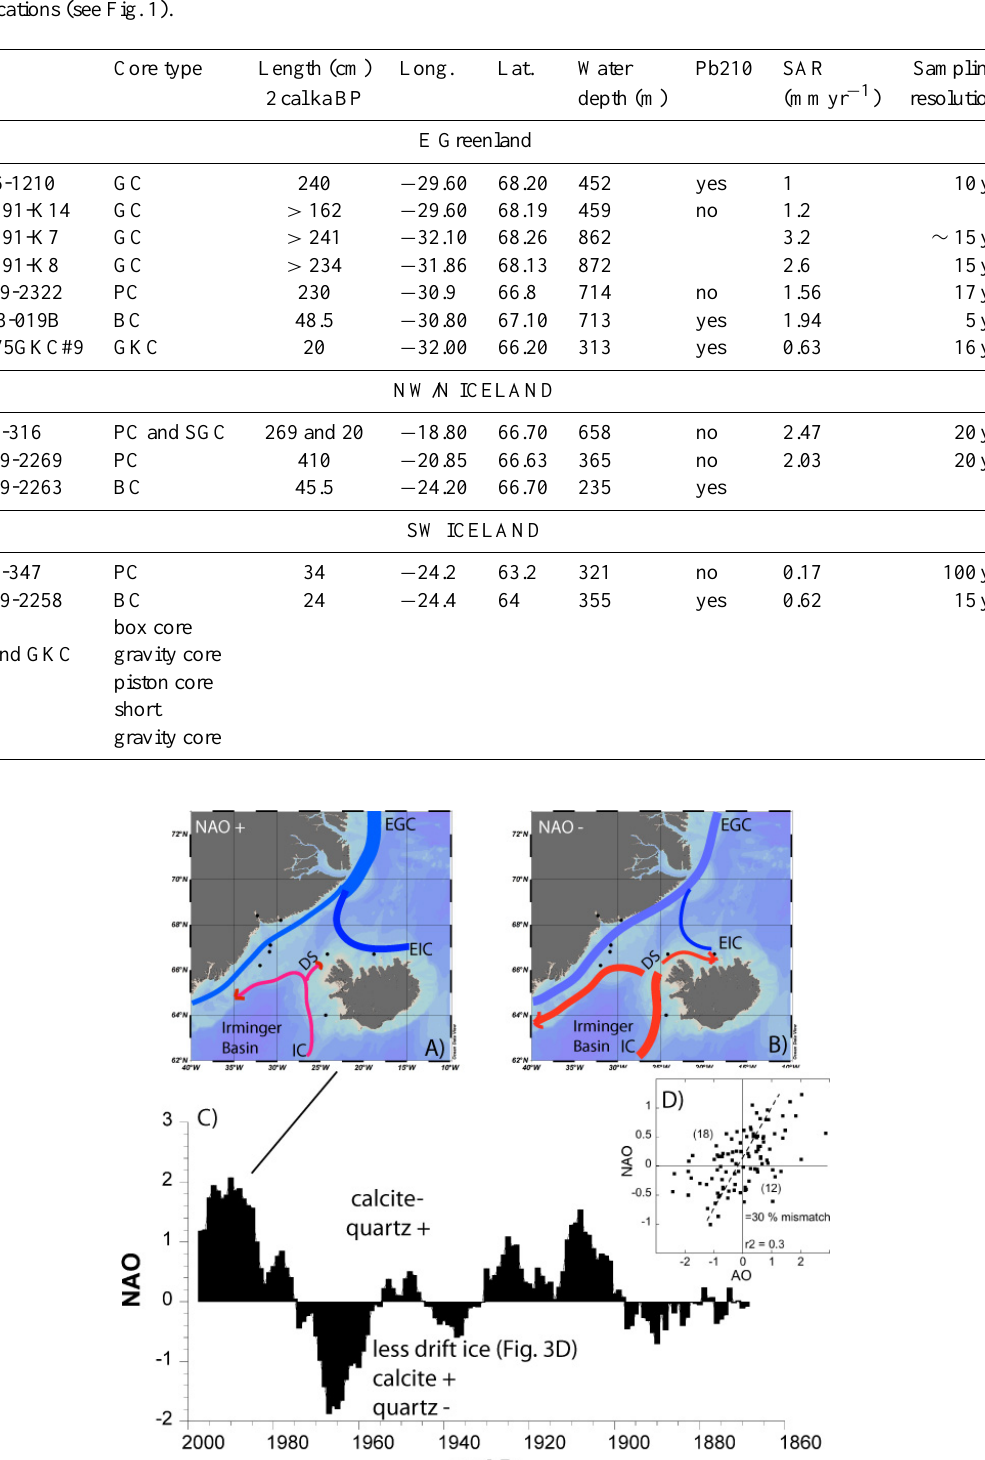
Table 1. Core locations (see Fig. 1).